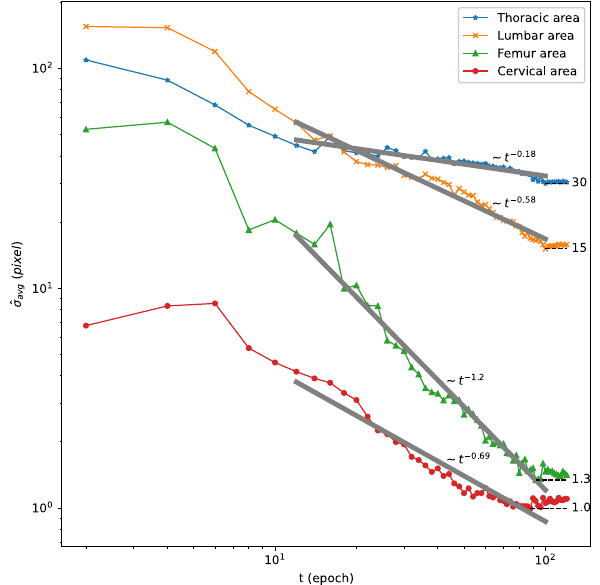
Figure 5. Learning speed of landmarks in different spinal areas. We categorised the landmarks of vertebral centres and femoral heads into four areas (cervical, thoracic, lumbar, and femoral heads) and plotted the per-area averaged standard deviation (SD) of the first-stage heatmaps against the training time (epoch), in log–log scale. From epoch 10 to epoch 100, we observed that the profiles of SDs had a tendency to decay as t − γ . We fitted the decaying profiles in log–log scale (grey solid lines) and estimated γ = 0.18 (thoracic area); γ = 0.58 (lumbar area); γ = 0.69 (femoral heads); and γ = 1.2 (cervical area). For all fitted results, the adjusted R 2 > 0.86 and p value < 10 − 4